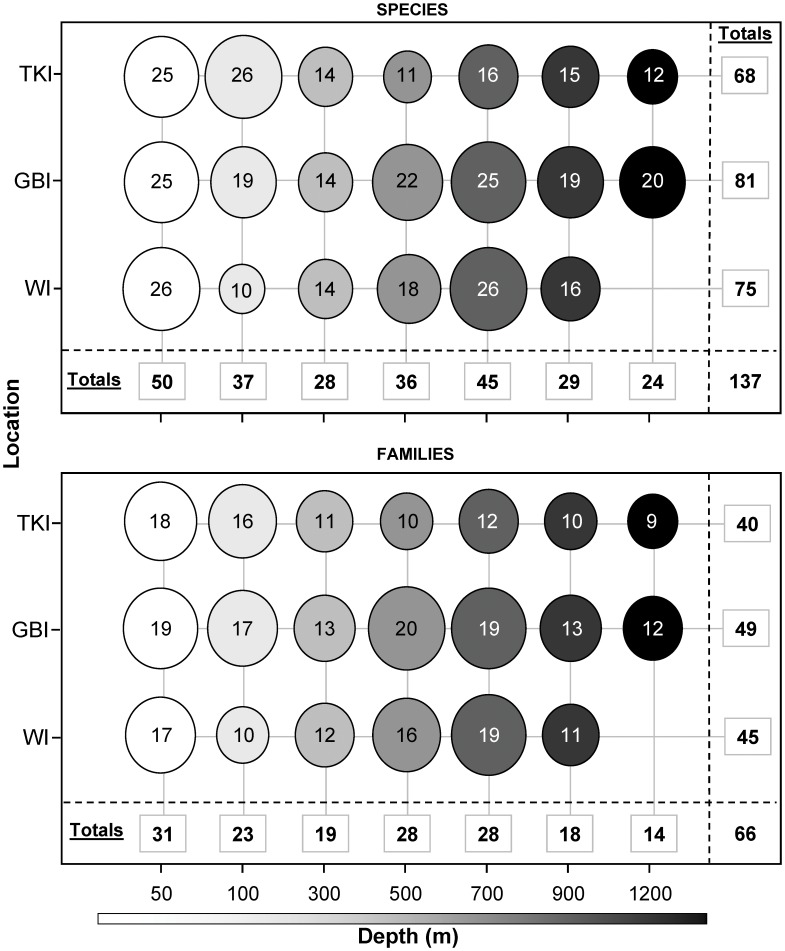
Family and species richness of fishes identified from video samples by depth and location.Each circle pools the information obtained from n = 6 two-hour video deployments and its diameter is proportional in size to the richness value at one location. Overall totals for depths and locations are given in the marginal columns and rows, respectively, with the grand total given in the bottom right-hand corner.